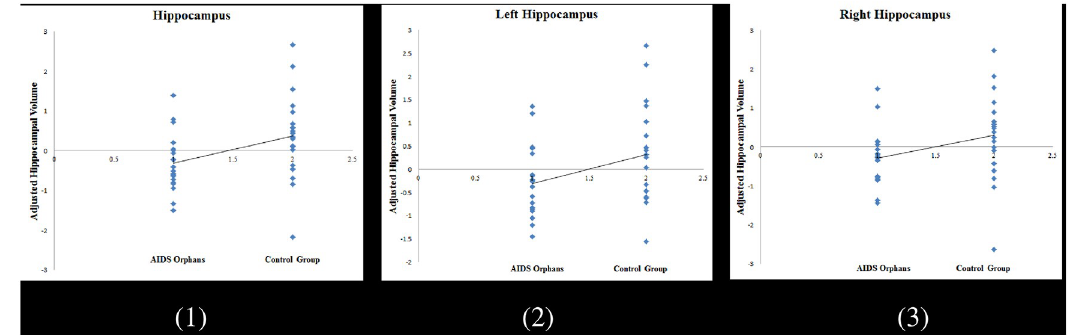
Fig 2. Gray matter volume in the hippocampus, which demonstrating a significant difference between AIDS orphans and normal adolescents (controlled for age, gender, and whole brain gray matter volume, (1) = Total hippocampus; (2) = Left hippocampus; (3) = Right